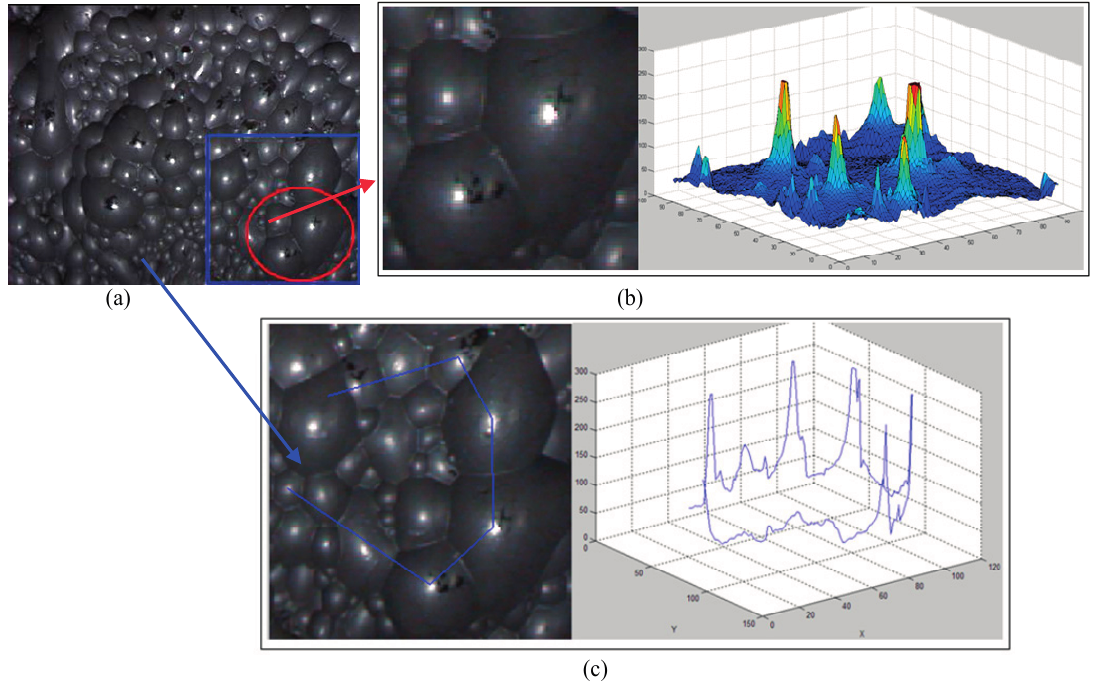
Figure 1. Gray value characteristics of the image of large bubbles. ( a ) a large bubble image; ( b ) left : a part of the image (a); right : the 3D surface of the left image; ( c ) left : large bubbles and the profile line; right : the gray level histogram of the profile corresponding to the left